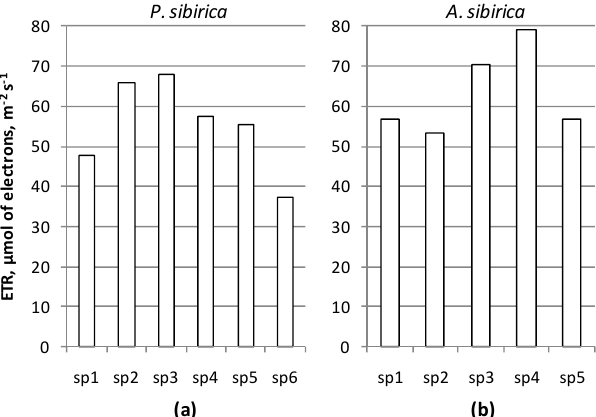
Figure 5. Change of electron transport rate (ETR) (white bars) along the study slope: ( a ) P. sibirica ; ( b ) A. sibirica . sp1–sp6 denote the numbers of sample points.